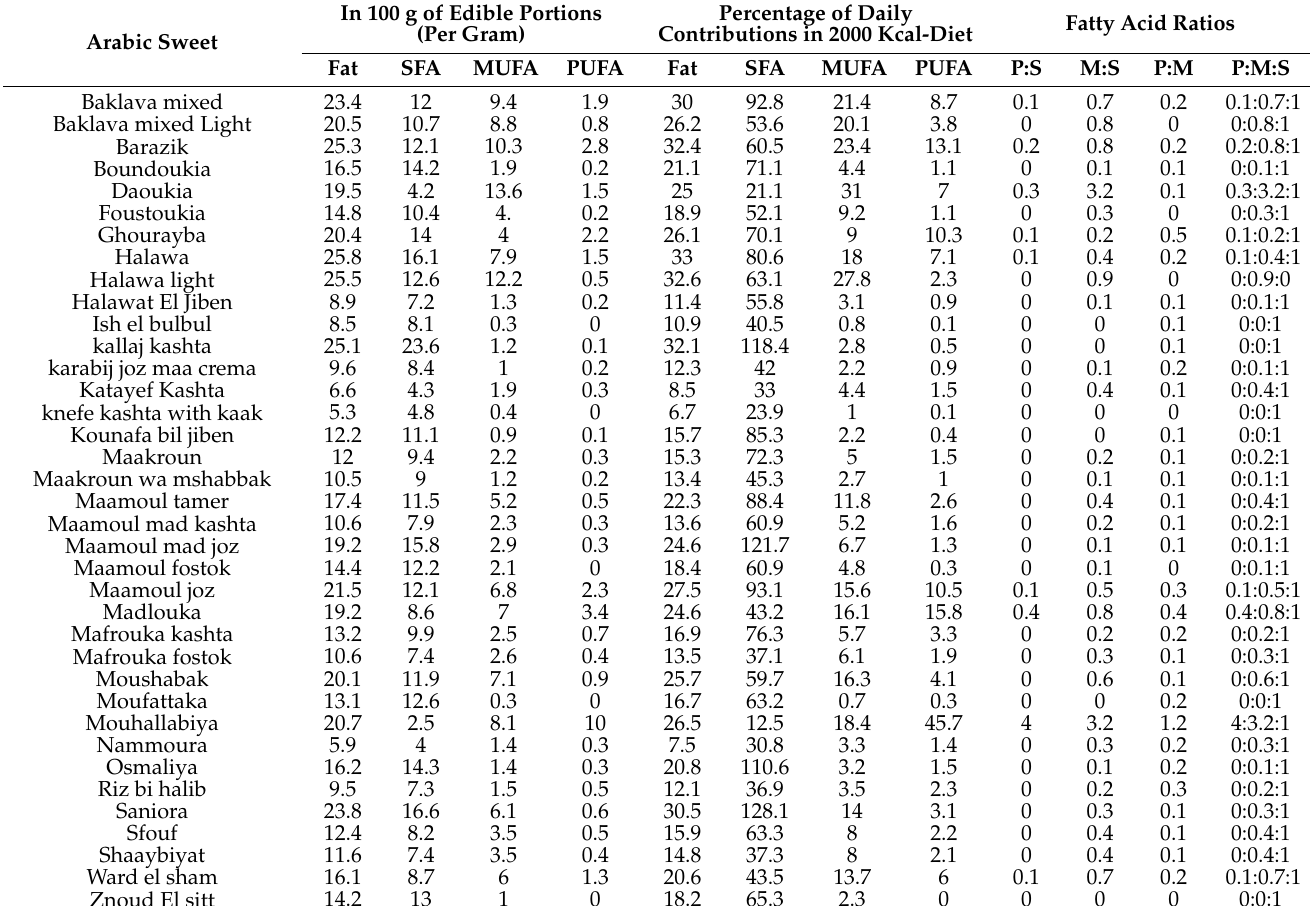
Table 2. Fatty acid ratios and total fatty acid mean values in 100 g of edible portions of Arabic sweets and the percentage of their daily contribution in a 2000